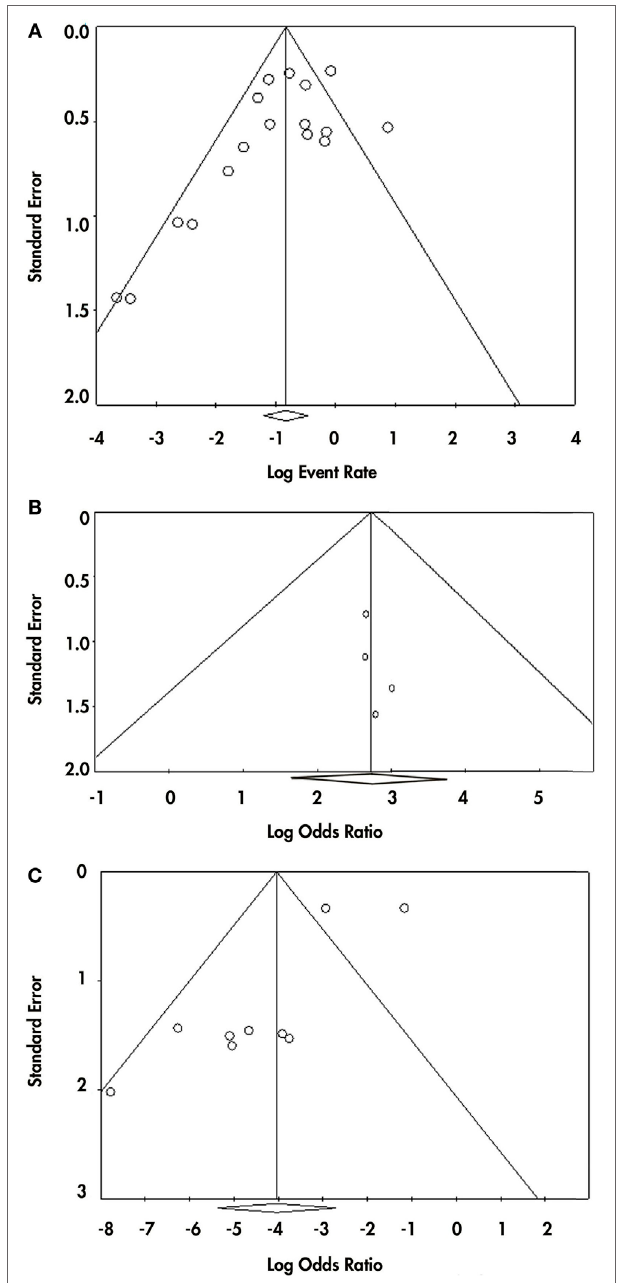
FigURe 2 | Publication bias for the three analysis made. Panel (a) shows the funnel plot from the event-rate analysis. Panel (B) shows the funnel plot from the prevalence of responsiveness in vascular parkinsonism (VP) subjects with nigrostriatal lesion vs. VP subjects without nigrostriatal lesion. Panel (c) shows the funnel plot from the prevalence of responsiveness in VP vs. Parkinson